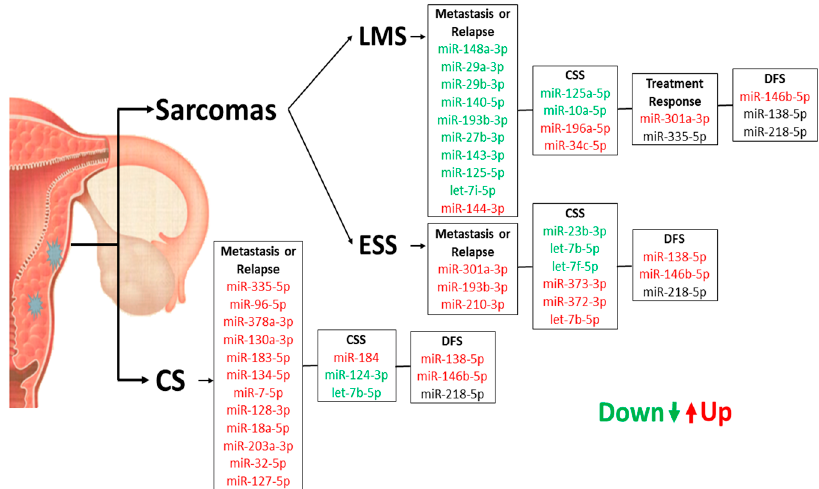
Figure 8. Summary of miRNA expression profiles in US and CS samples concerning their prognostic role for patients.